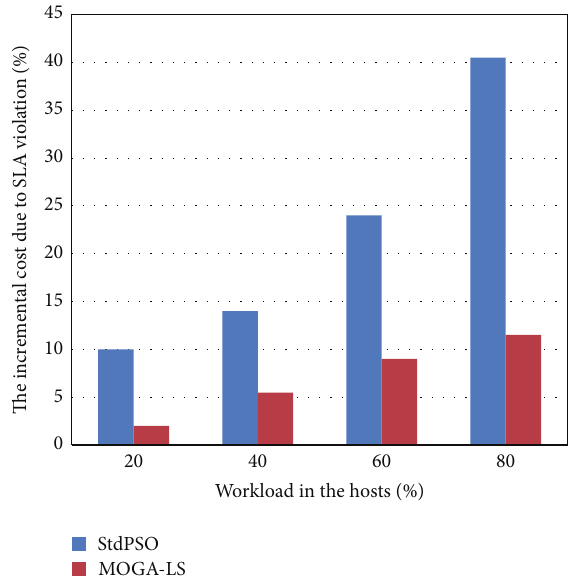
Figure 9: Comparison of the incremental cost due to SLA violation in VM migration with varying percentage of load in the cloud data